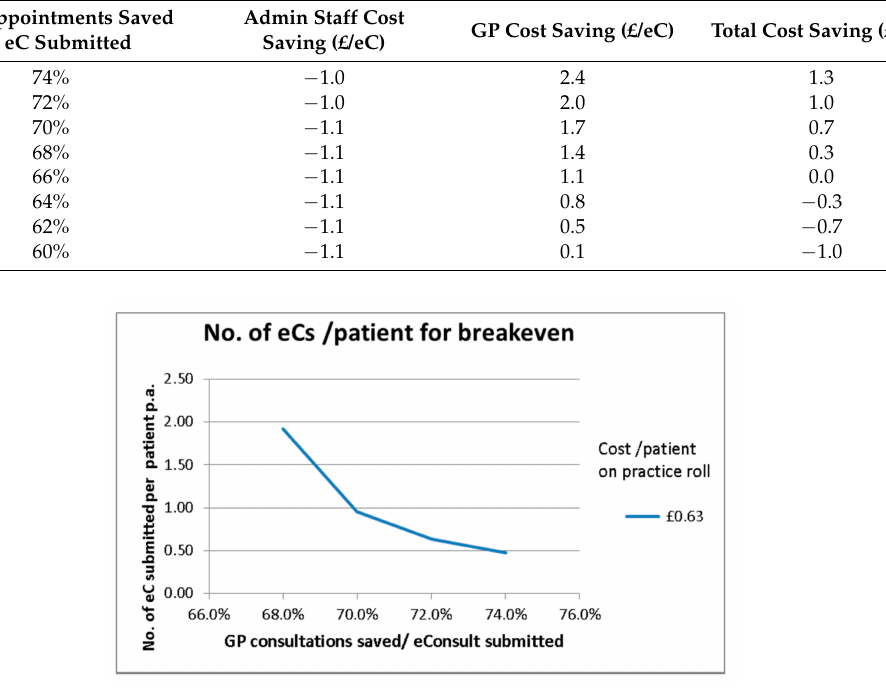
Table 4. Cost savings for different assumptions of %GP appointments saved per eConsult submitted.